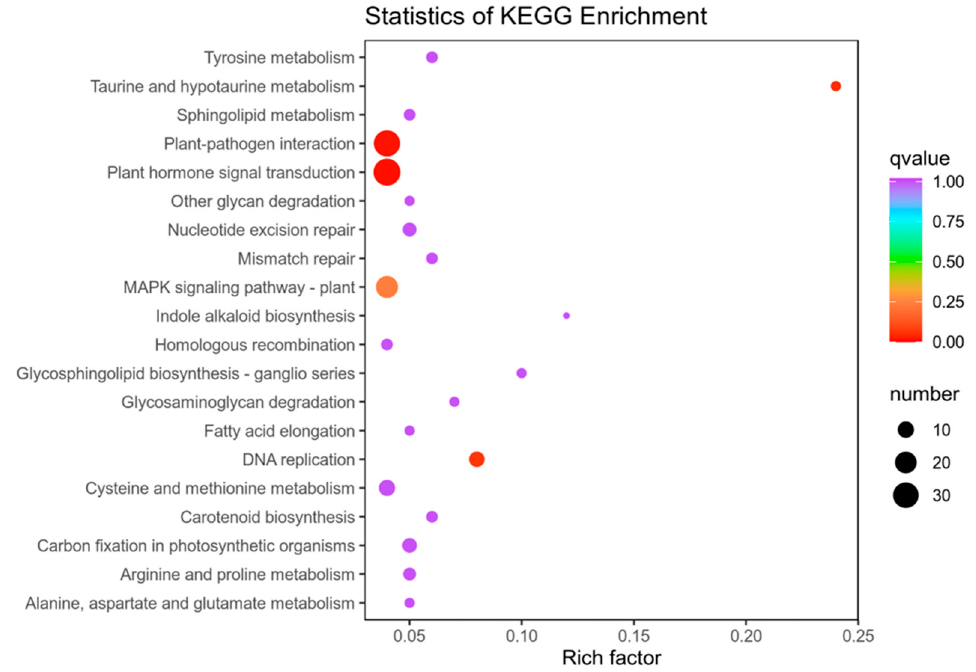
Figure 6. KEGG pathway enrichment analysis of DEGs between 6D3 and 6DUP.